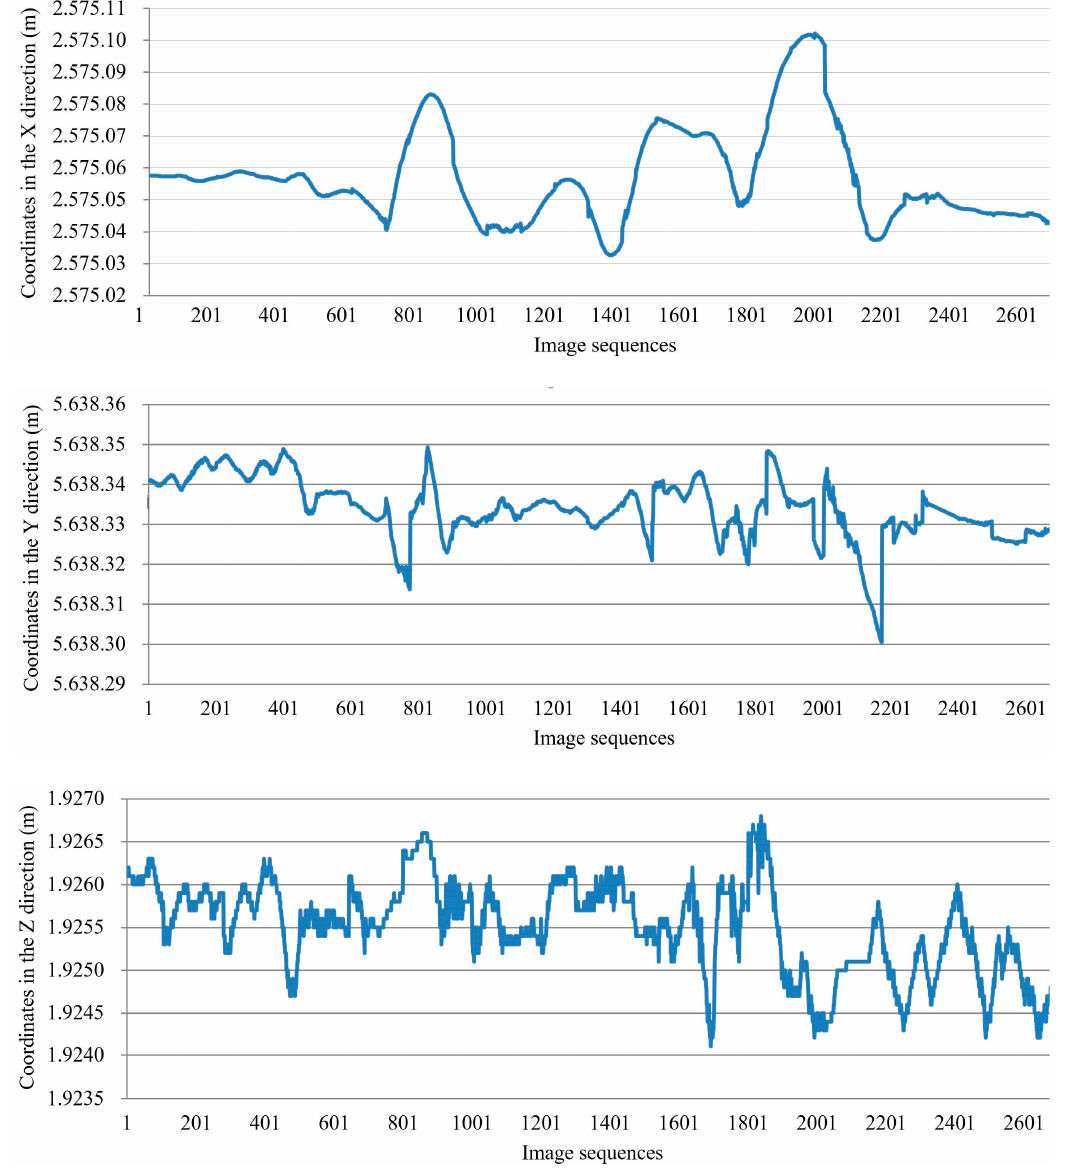
Figure 12. Displacement curves of the tracking target T1 in the three directions.